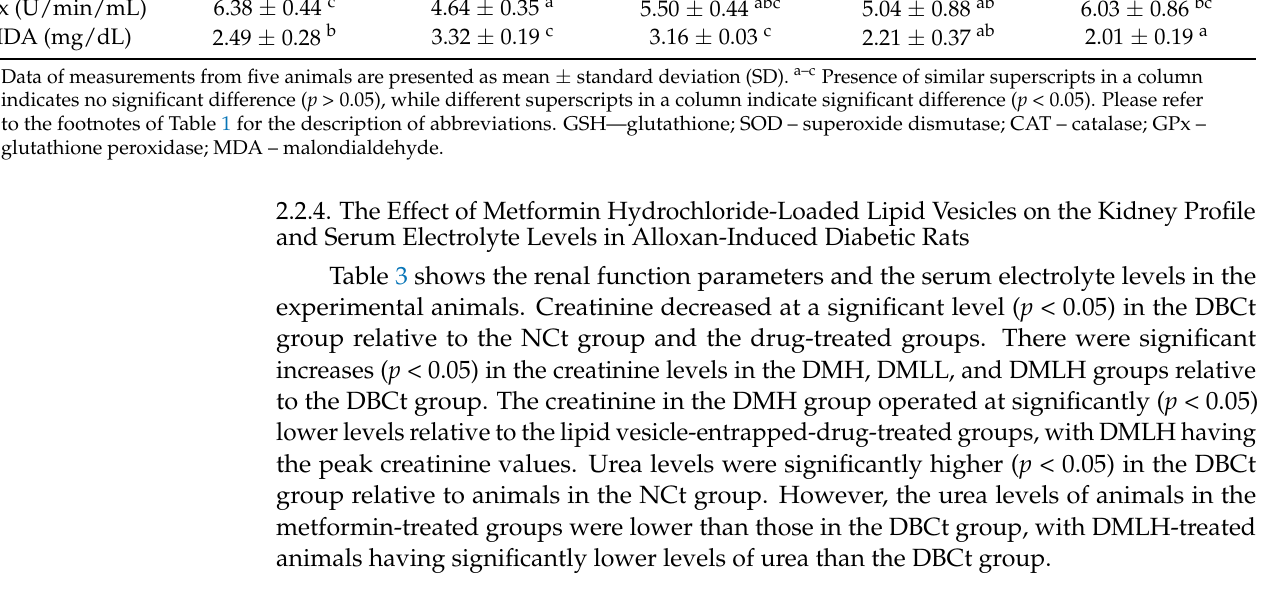
Table 3. Renal function status and serum electrolyte levels in different groups of animals at the end of the experimental period.